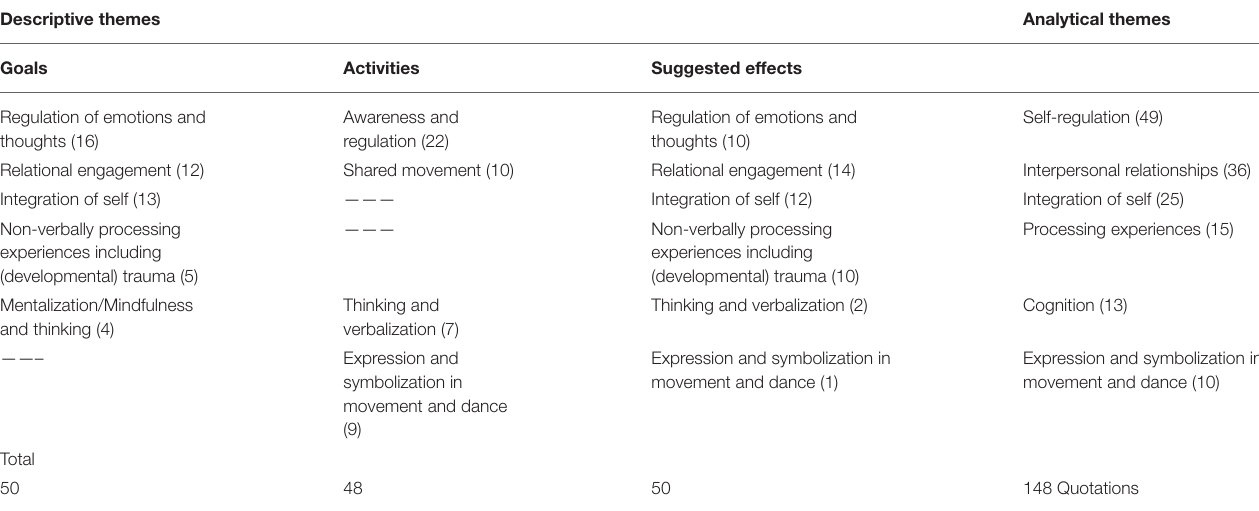
TABLE 4 | Overview of descriptive and analytical